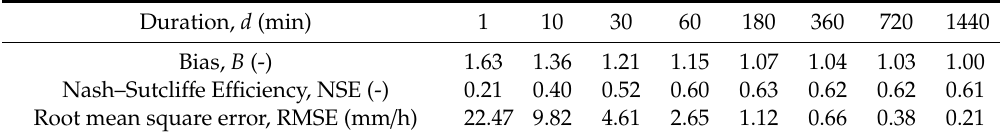
Figure 3. Example of estimation of bias between radar and rain gauge intensities at rainfall durations of 10 ( a ), 60 ( b ) and 1440 ( c ) min for the 500 × 500 m 2 resolution. Table 1. Bias between radar and rain gauge intensities at different rainfall durations for the pixel size of 500 × 500 m 2 .